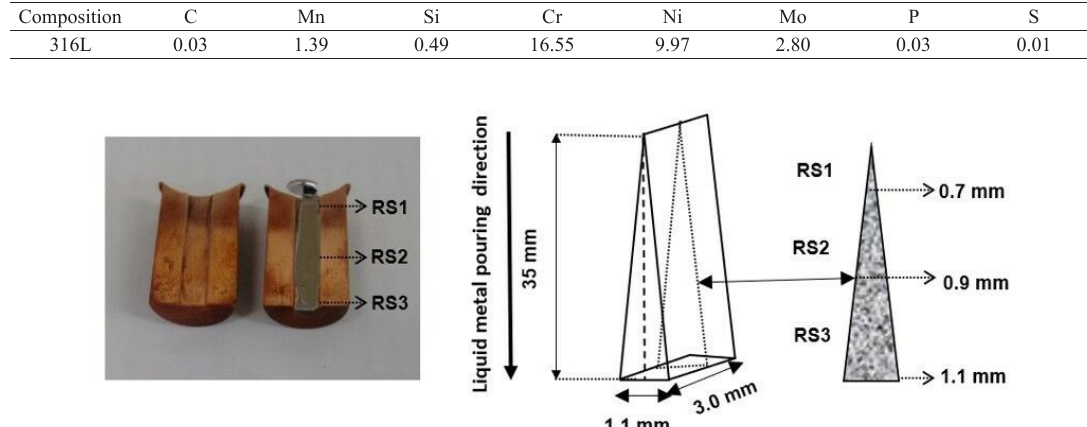
Figure 1. Alloy melted by rapid solidification in the copper mold, indicating the regions of analysis and schematic representation of the region and dimensions of the samples. The hatched region indicates the normal direction